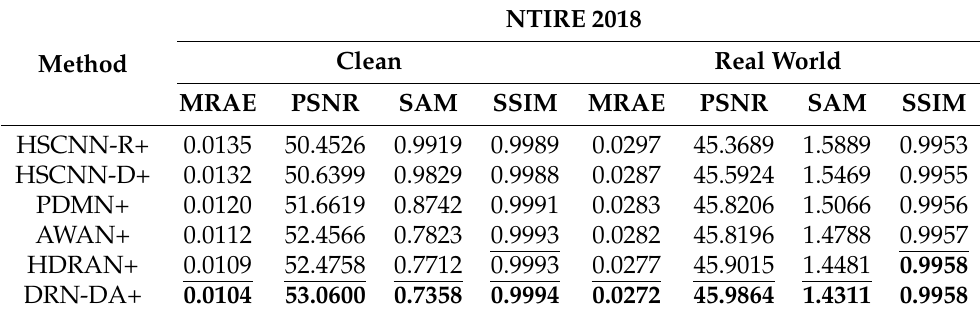
Table 3. Comparison between the proposed method and other state-of-the-art methods with the ensemble strategy based on the NTIRE 2018 data